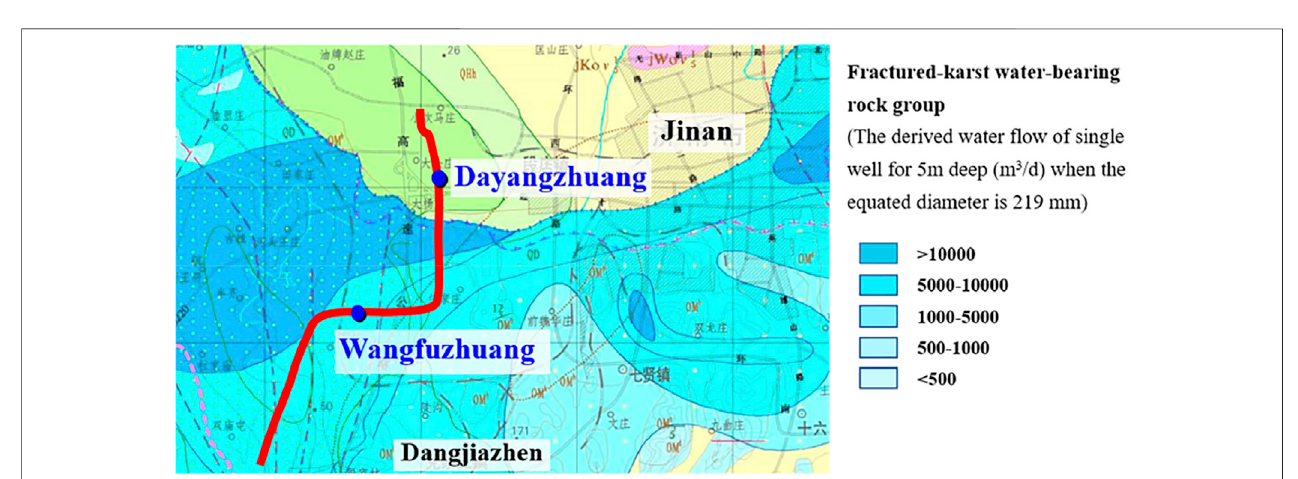
FIGURE 3 | Hydrogeological map of the limestone section on the right line.